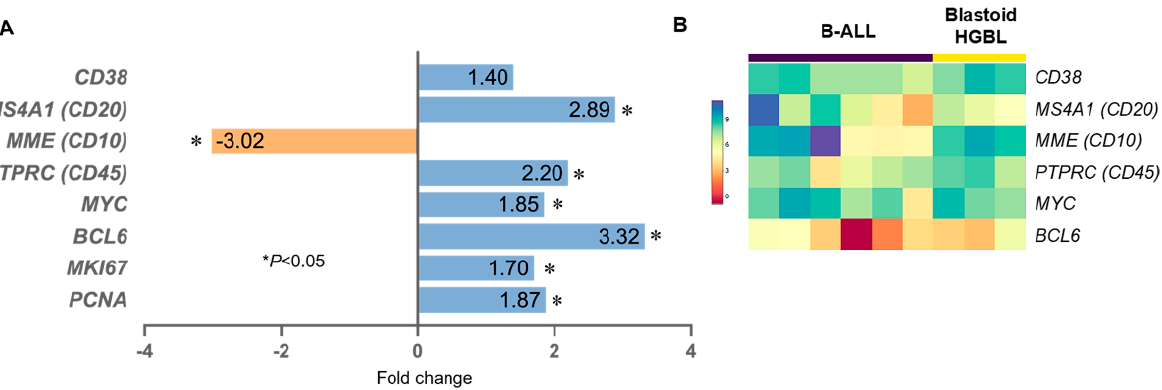
Figure 4. Comparison of the mRNA expression level of the six genes included in the two scoring systems between blastoid HGBL versus B-ALL. ( A ) Average gene expression level of blastoid HGBL in comparison with B-ALL. The two genes encoding Ki67 and PCNA for proliferation rate assessment are also included for comparison. ( B ) Heatmap of these 6 genes for the 9 cases with misleading scores in the two scoring systems.